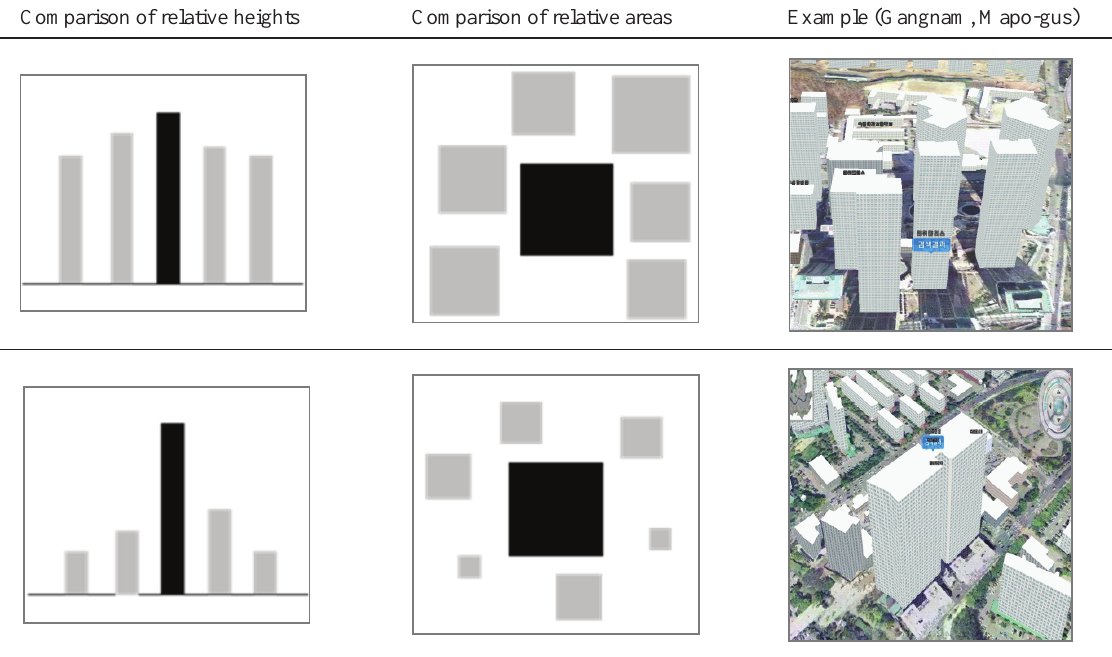
table 3. the relativity of height and area of super high rise building Comparison of relative